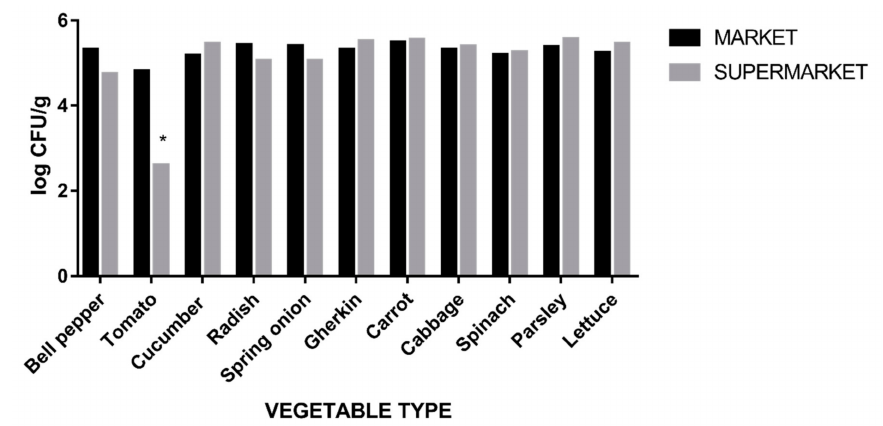
Figure 2. Average Enterobacteriaceae CFU counts, comparison between vegetables obtained from farmer markets and supermarkets, * = p < 0.05.